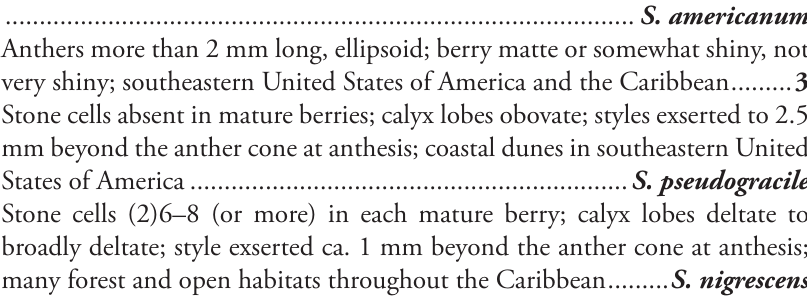
Artificial key to the species of the Morelloid Clade occurring in North America (Canada and the United States [except Hawaii]) 1 Foliage with glandular trichomes, the plants sticky to the touch ................. 2 – Foliage lacking glandular trichomes (sometimes with a few scattered tri- chomes with glandular tips, not markedly glandular); plants not sticky to the touch .......................................................................................................... 6 2 Mature berry orange, red or dark yellow, usually somewhat ellipsoid; calyx lobes with translucent sinuses; rare weed of disturbed places ....... S. villosum – Mature berry green, purple or black, usually globose or subglobose; wide- spread weedy species ................................................................................... 3 3 Calyx lobes enlarged in fruit and enclosing the berry .................................. 4 – Calyx lobes not enlarged and enclosing the berry ........................................ 5 4 Leaf bases attenuate to cuneate; inflorescences mostly internodal, with 4–8 (–10) flowers; corolla with a central greenish yellow star with black or purple margins; berries dark green to greenish brown, marbled with white, becom- ing translucent and shiny; stone cells 1–3, ca. 0.5 mm in diameter ............... ........................................................................................ S. nitidibaccatum – Leaf bases cordate or truncate; inflorescences mostly leaf-opposed, with 2–5 (–7) flowers; corolla with a central greenish yellow star without black or pur- ple margins; berries pale green, not marbled with white, becoming matte, opaque; stone cells 4–6, 0.8–1 mm in diameter .................... S. sarrachoides 5 Inflorescences with the flowers clustered near the tips; anthers 1.1.3–1.8 mm long; mature berry matte with a glaucous cast; seeds 1.3–1.5 mm long; culti- vated ...................................................................................... S. retroflexum – Inflorescences with flowers spaced along the rhachis; anthers 1.8–2.5 mm long; mature berry matte, but not glaucous; seeds 1.8–2 mm long; adven-